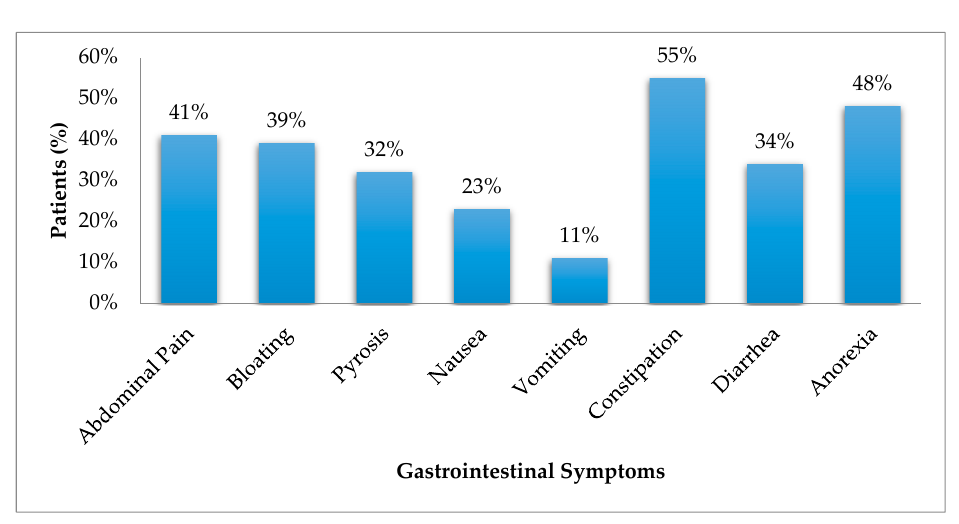
Table 2. Prevalence and severity of Gastrointestinal Symptoms.